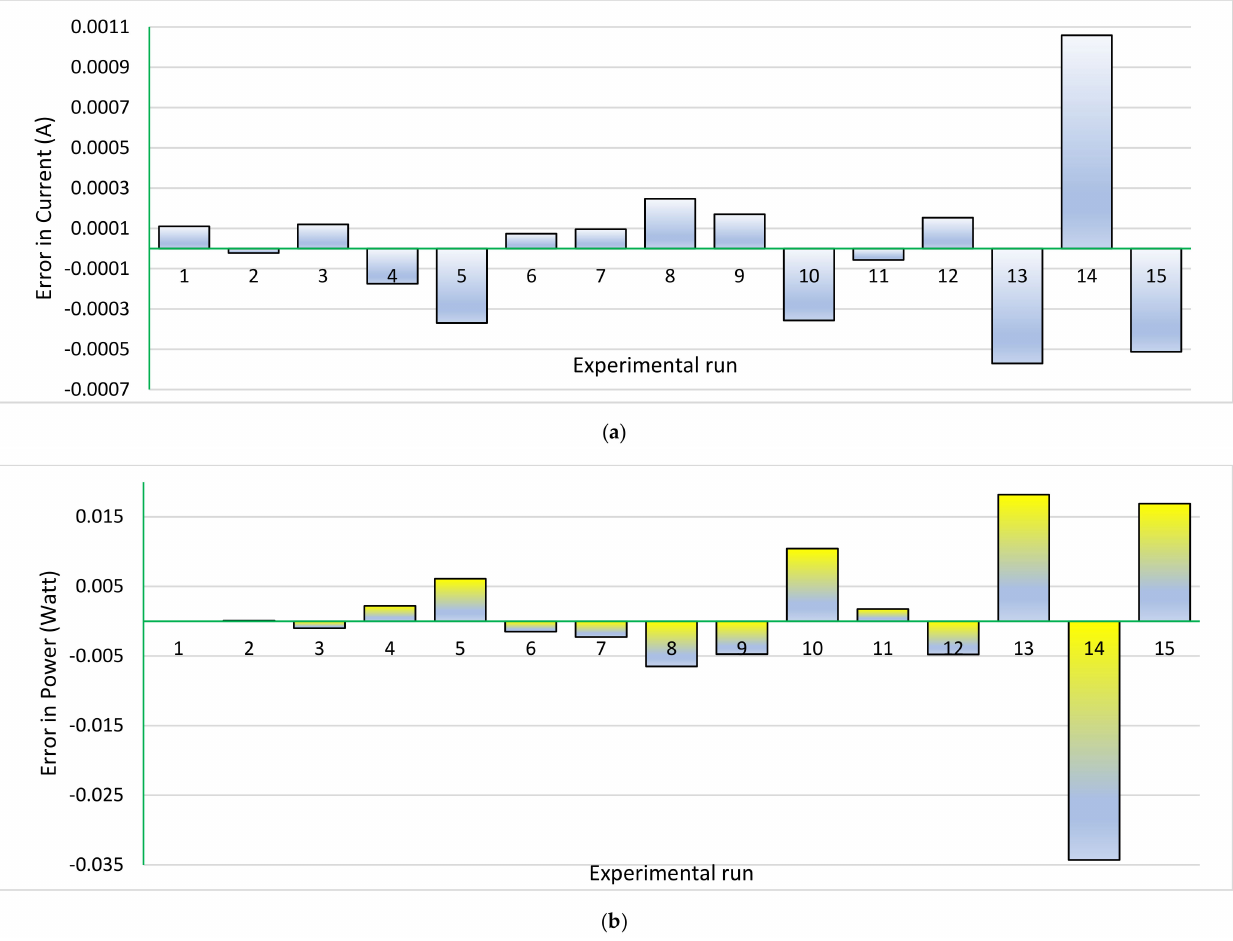
Figure 23. Error values for KC200GT TDM based on TFWO: ( a ) Current error values and ( b ) power error